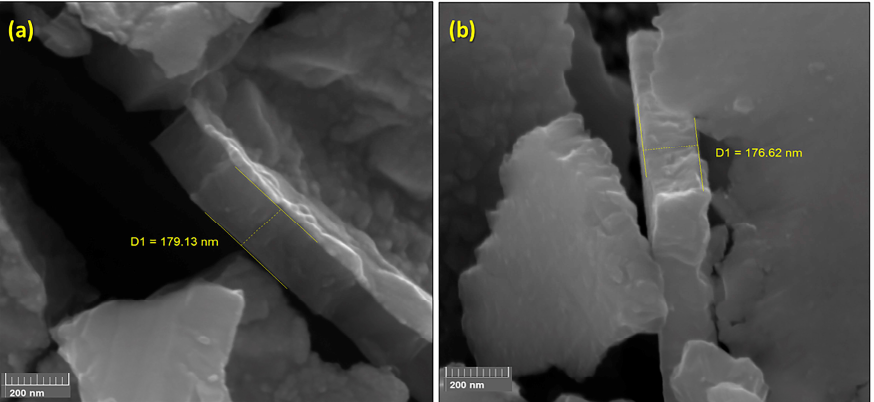
Figure 2. ( a ) AFM image of the AISI 316L surface before film deposition. ( b ) FEG-SEM image of the TiO 2 thin film deposited on AISI 316L (magnification of 80k × ). ( c ) AFM image of the TiO 2 film surface.